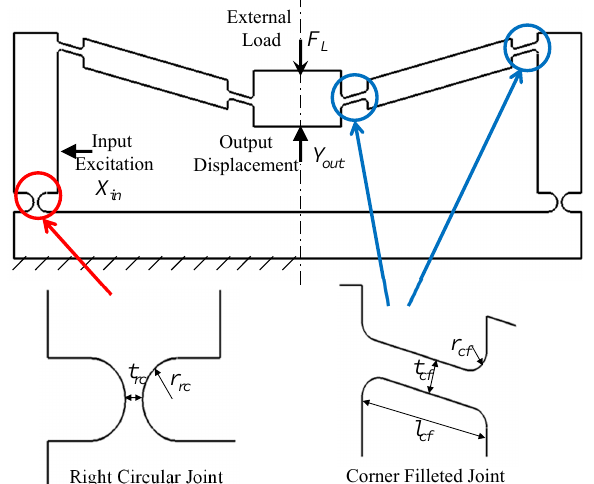
Figure 1. Symmetric five-bar mechanism schematic showing flexure joints